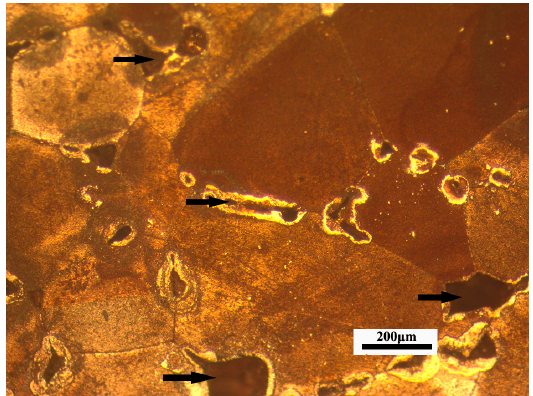
Figure 13. Optical Metallographic Microstructure of a sintered specimen with heating rate (3 °C/min), highest temperature (1083 °C), holding time (3 h); ×50 magnification (Black arrows indicate some microscopic defects).